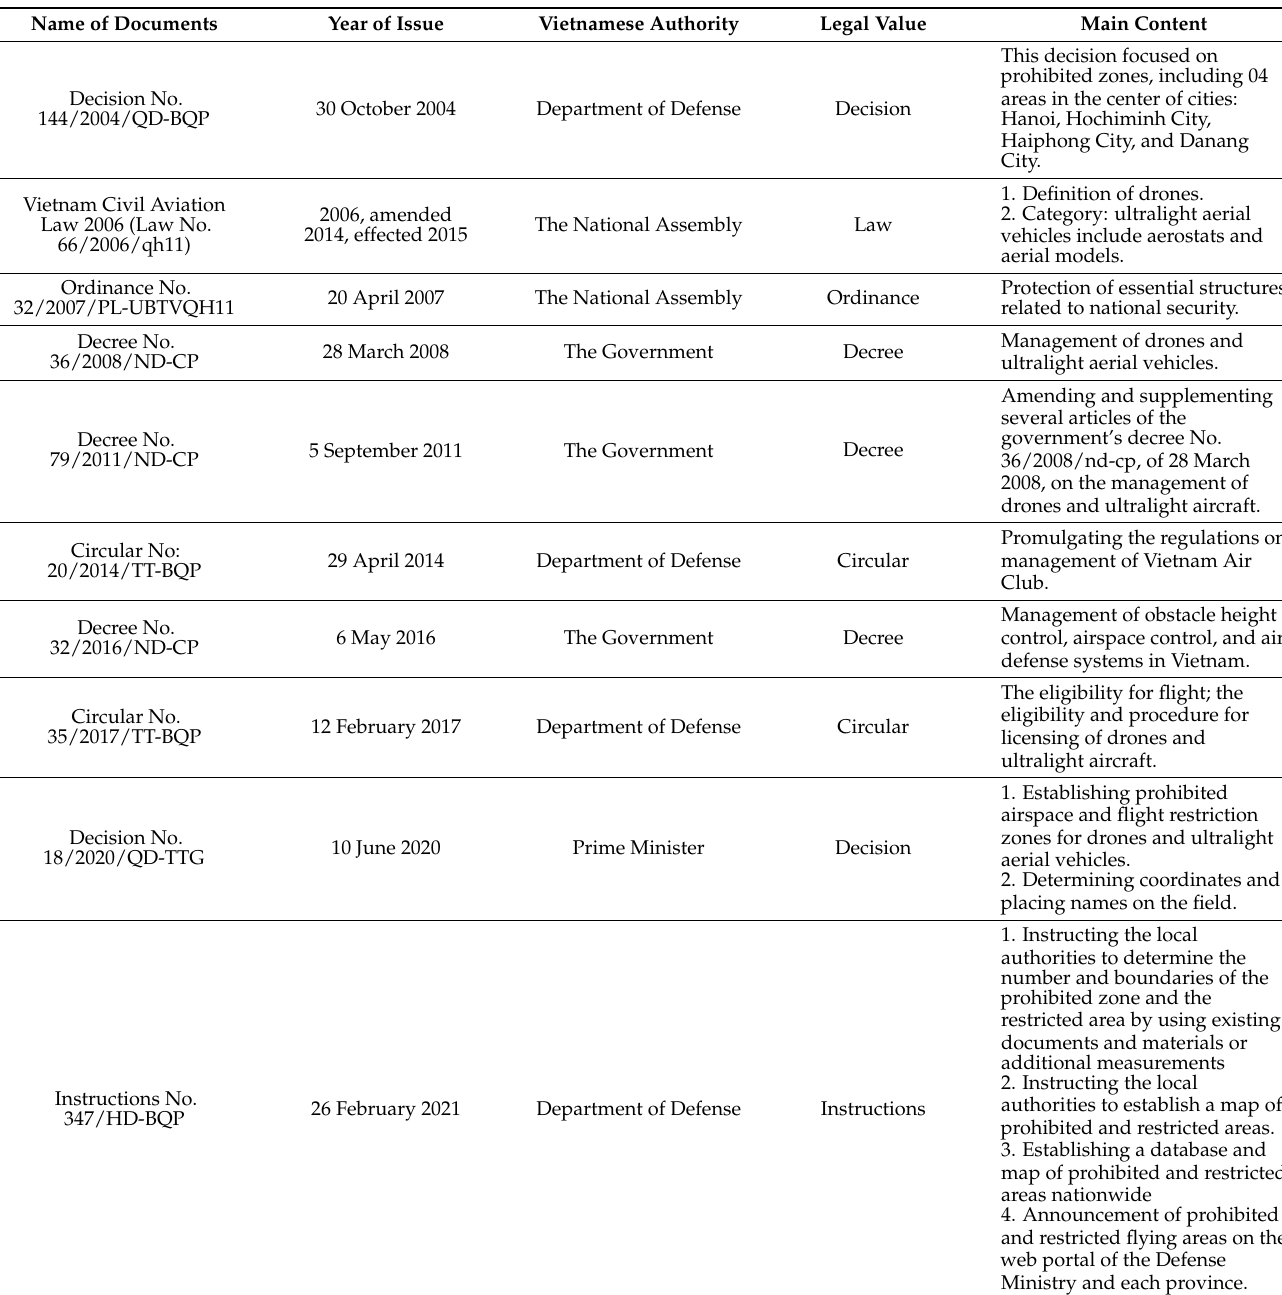
Table 1. Vietnamese legal on drone